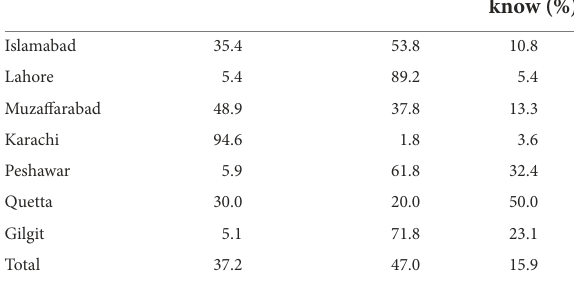
TABLE 5 Respondent’s opinion (%) about affordability of aflatoxin control in